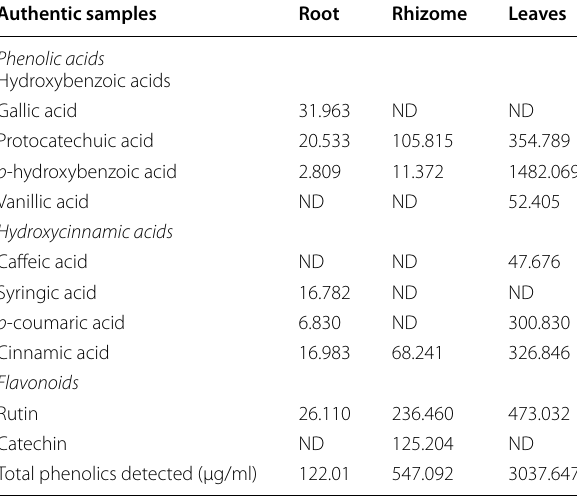
Table 3 Phenolic compounds (μg/ml) detected in RO, Rh and L crude extract using HPLC spectral